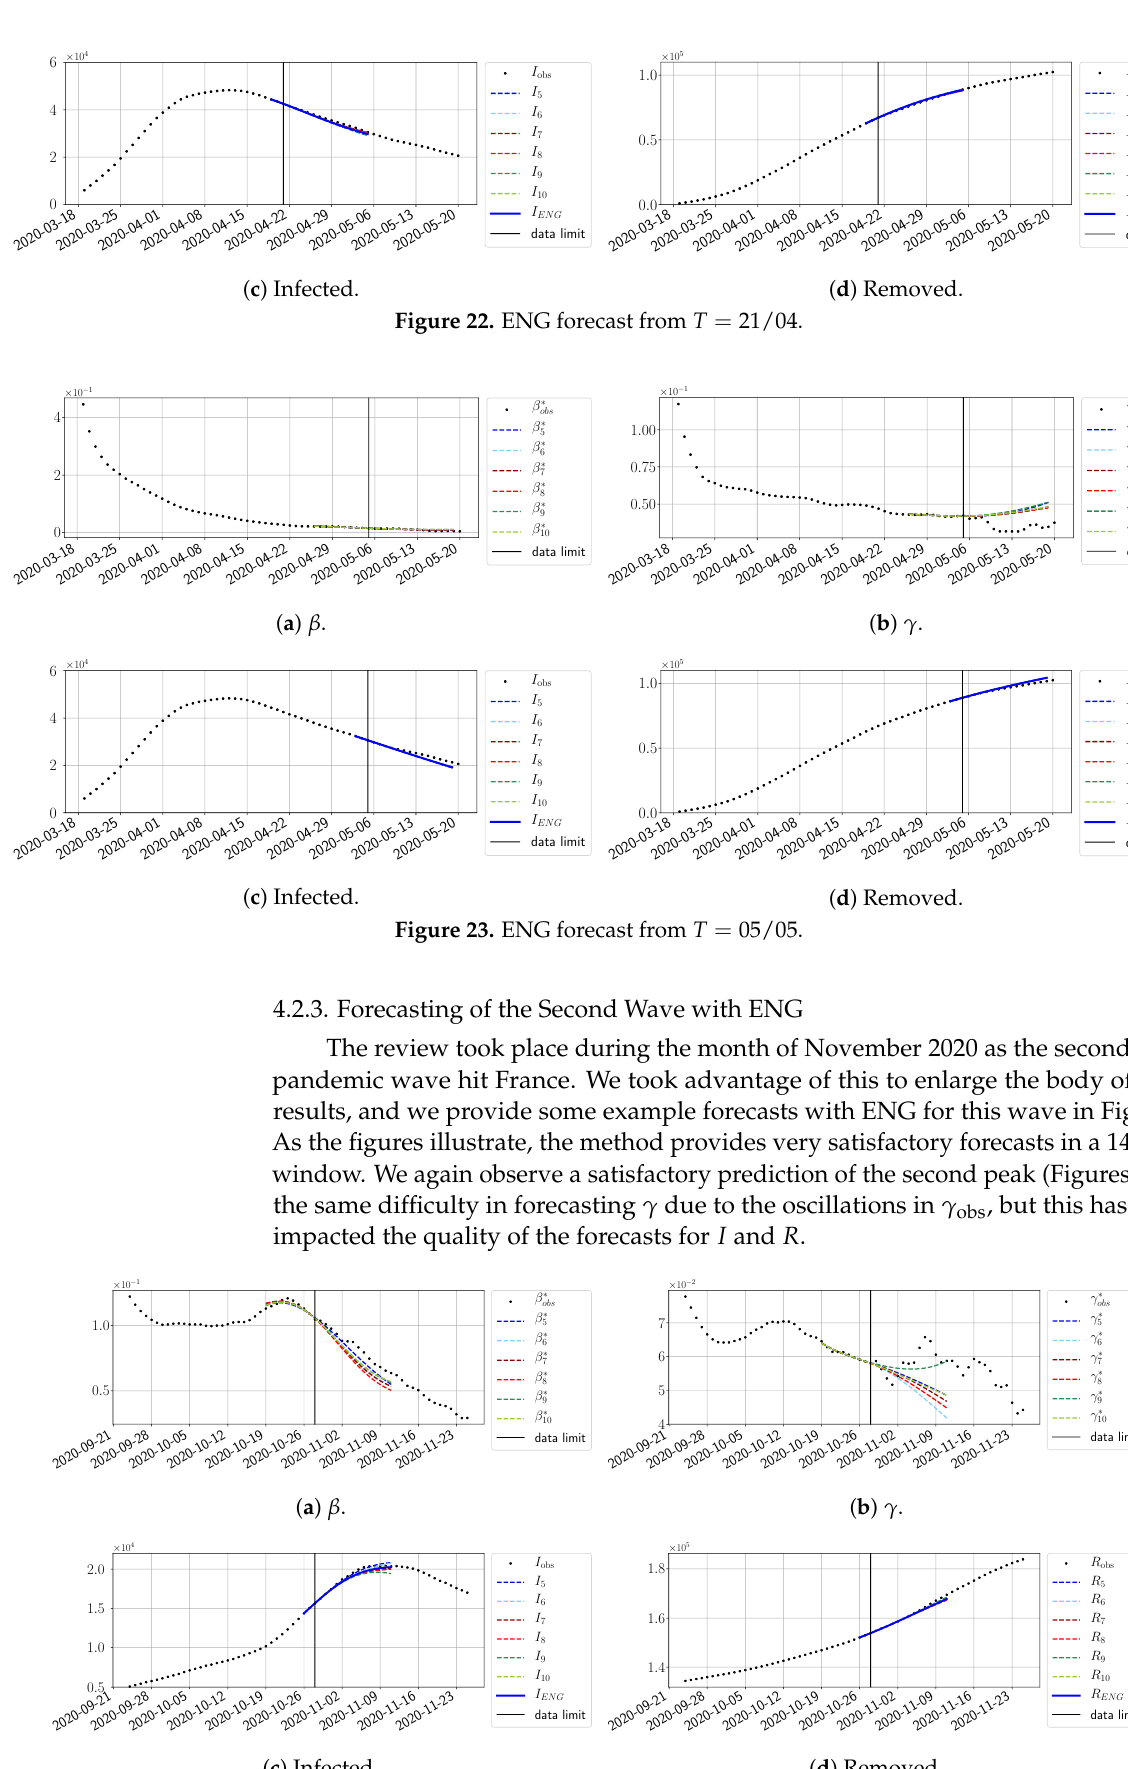
Figure 24. ENG forecast from T =